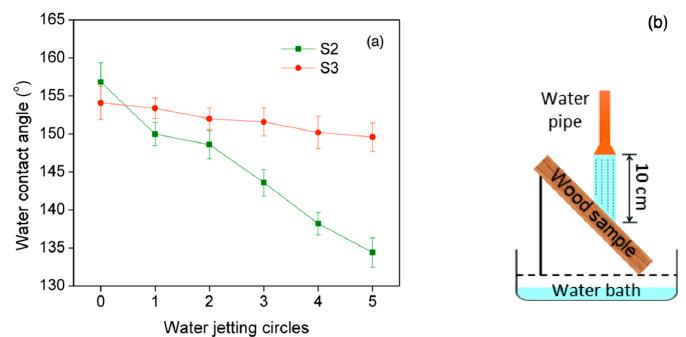
Figure 7. ( a ) The results of water contact angle (WCA) measurement and ( b ) schematic illustration of